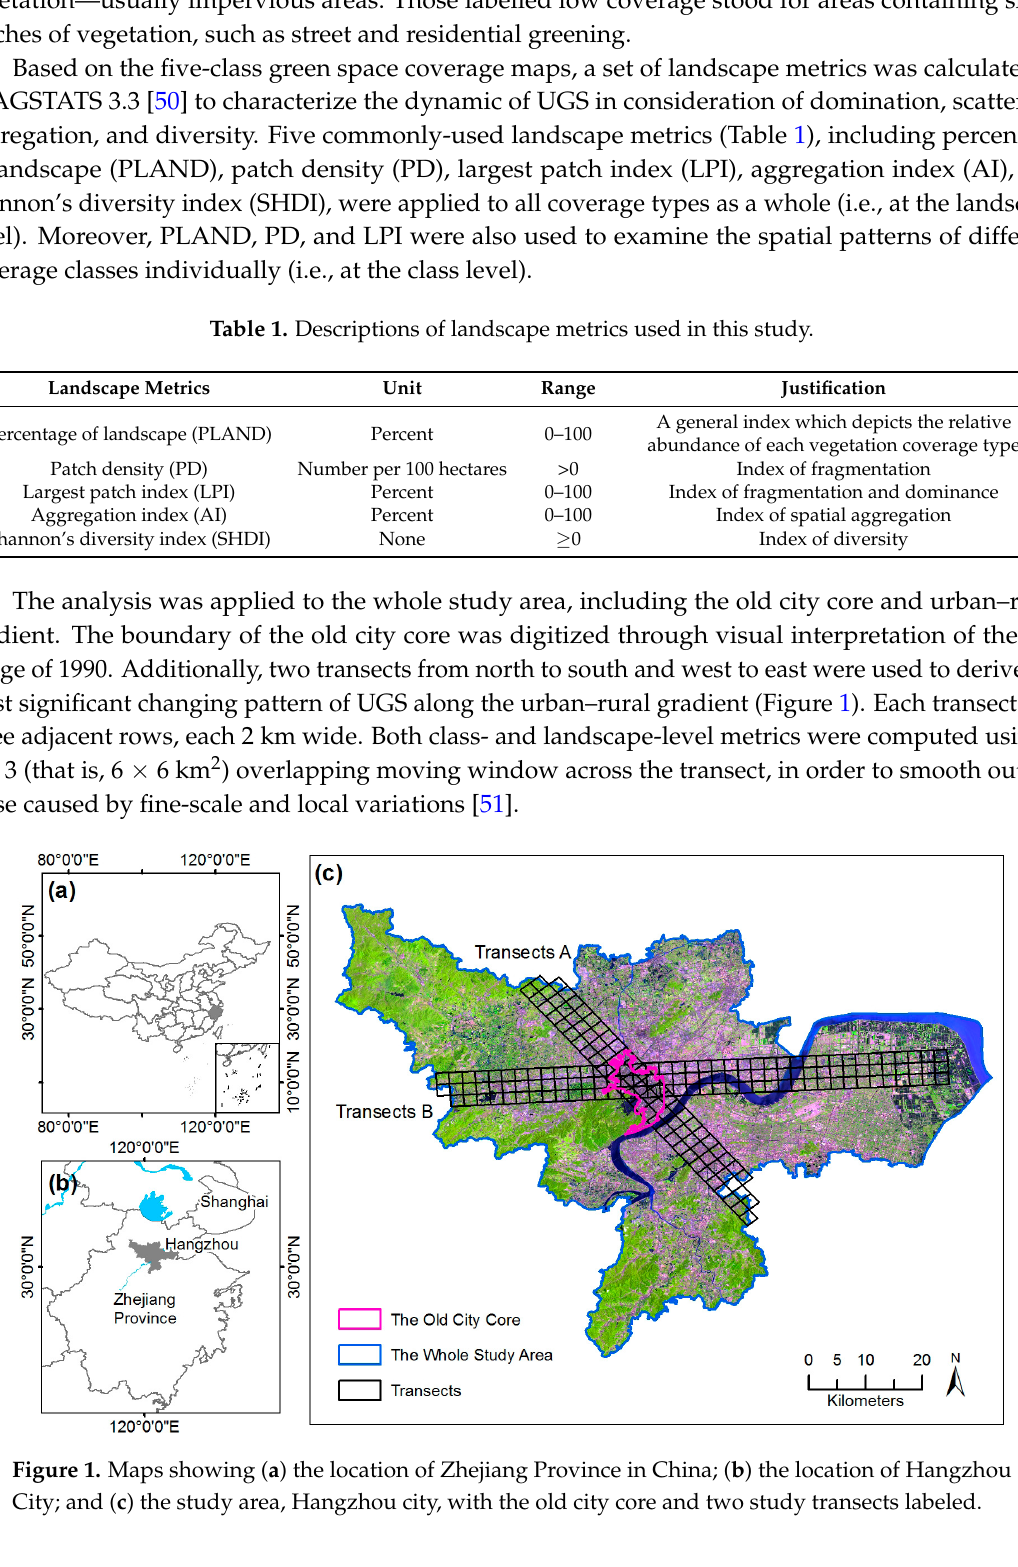
Table 1. Descriptions of landscape metrics used in this study.